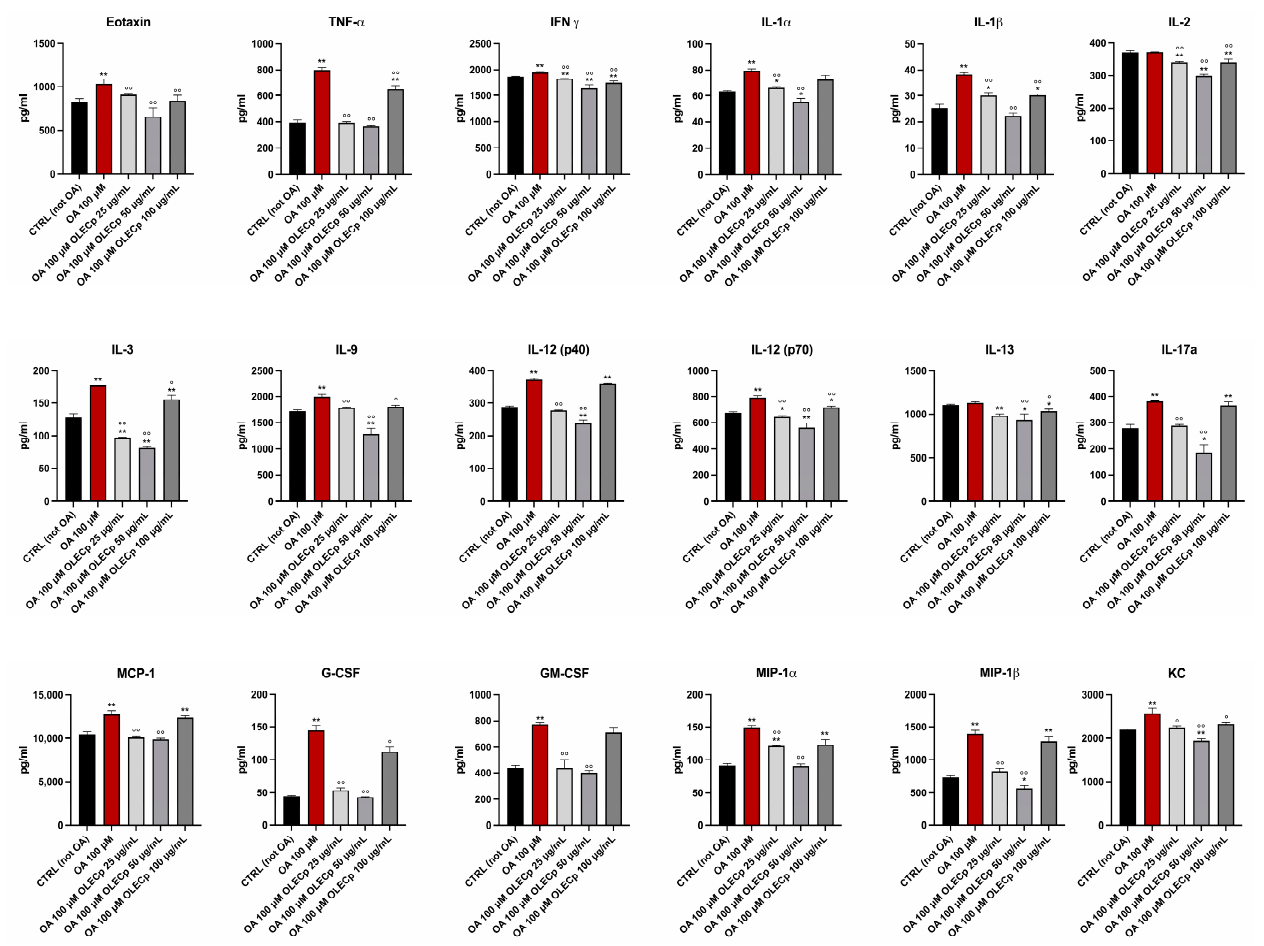
Figure 11. OLECp reduced pro-inflammatory cytokines expression in McA-RH7777 cells exposed to OA 100 μ M. Data are expressed as mean ± S.E.M. *: p < 0.05, **: p < 0.01 vs. CTRL; °: p < 0.05, °°: p < 0.01 vs. OA 100 μ M. TNF- α : tumor necrosis factor alpha, IFN γ : Interferon gamma, IL-1 α : Inter- leukin-1 alpha, IL-1 β : Interleukin-1 beta, IL-2: Interleukin-2, IL-3: Interleukin-3, IL-9: Interleukin-9, IL-12 (p40): Interleukin-12 (p40), IL-12 (p70): Interleukin-12 (p70), IL-13: Interleukin-13, IL-17: In- terleukin-17a, MCP-1: monocyte chemoattractant protein 1, G-CSF: Granulocyte colony stimulat- inflammatory protein-1 alpha, MIP-1 β : Macrophage inflammatory protein-1 beta, KC: Keratino-